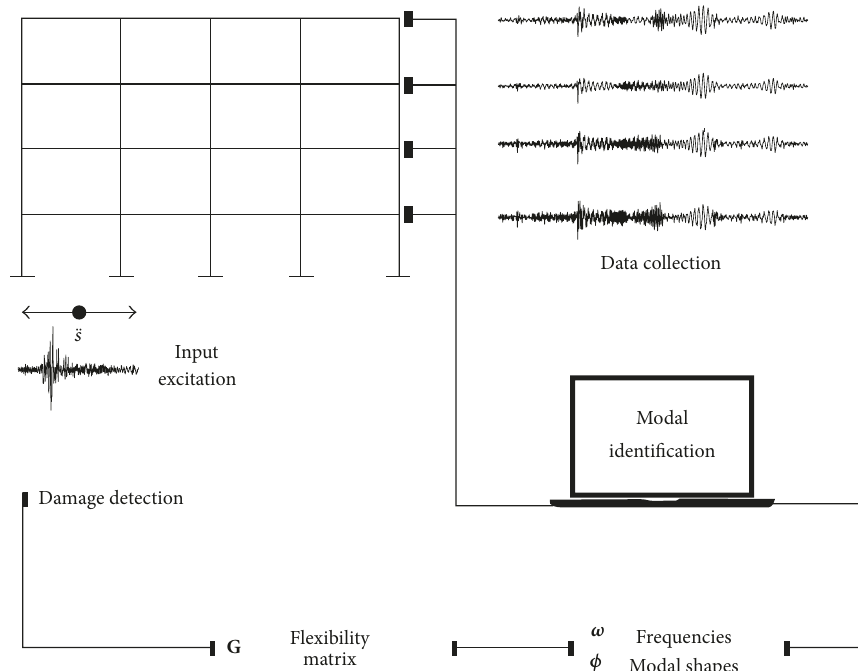
Figure 1: Synthetic scheme of a flexibility-based damage detection